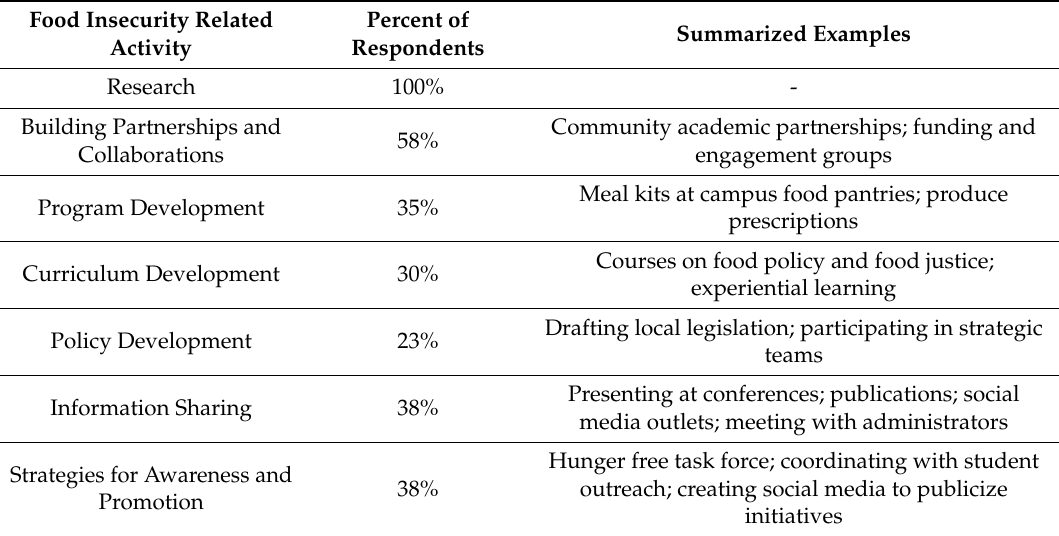
Table 1. Respondents’ primary activities related to food